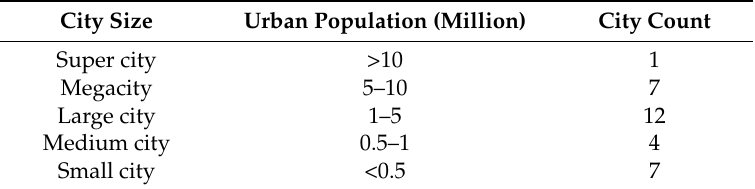
Table 4. Criteria for the categorization of city